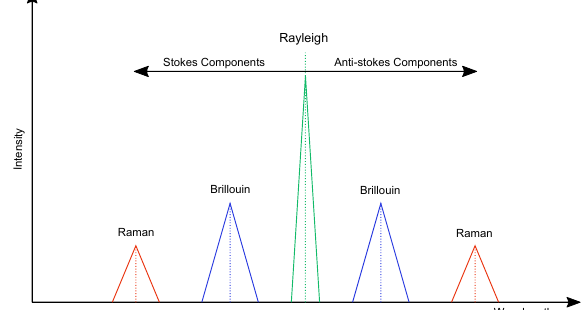
Figure 3. Schematic displaying Rayleigh, Raman, and Brillouin peaks in the electromagnetic spectrum. Frequency increases to the right; and wavelength to the left. (Adapted from